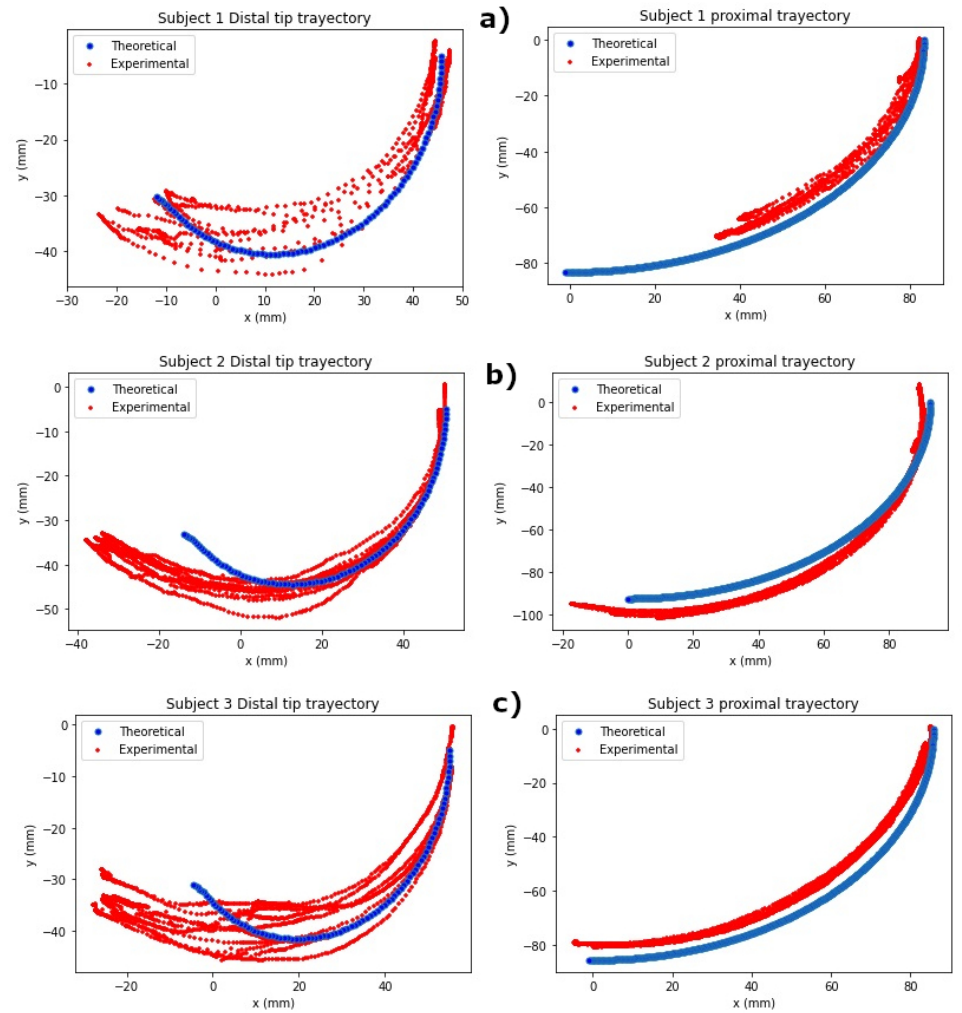
Figure 6. Experimental vs. theoretical trajectories of the first and second DOF for: ( a ) subject 1, ( b ) subject 2, and ( c ) subject